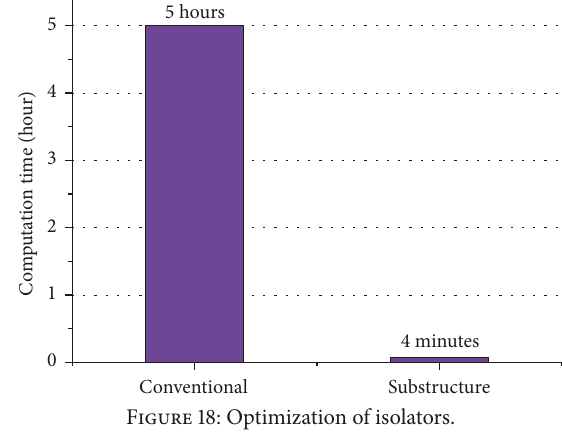
Figure 18: Optimization of isolators.